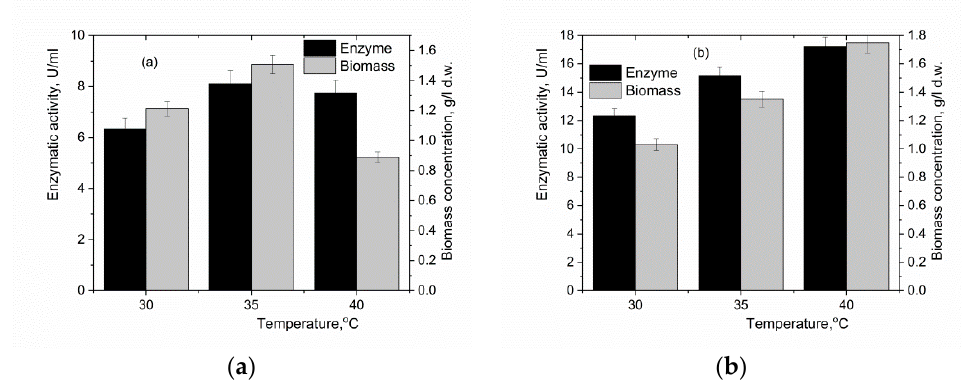
Figure 6. Variation of α -amylase activity and A. terreus biomass concentration with temperature on the third day of fermentation without n -dodecane ( a ) and with 5% vol. n -dodecane ( b ) (pH = 6).